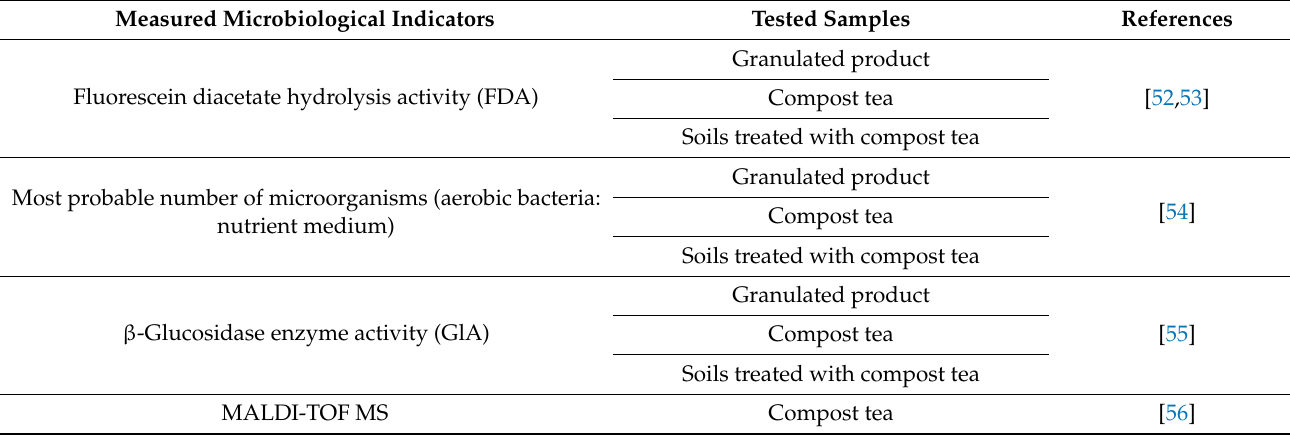
Table 3. Evaluated microbiological